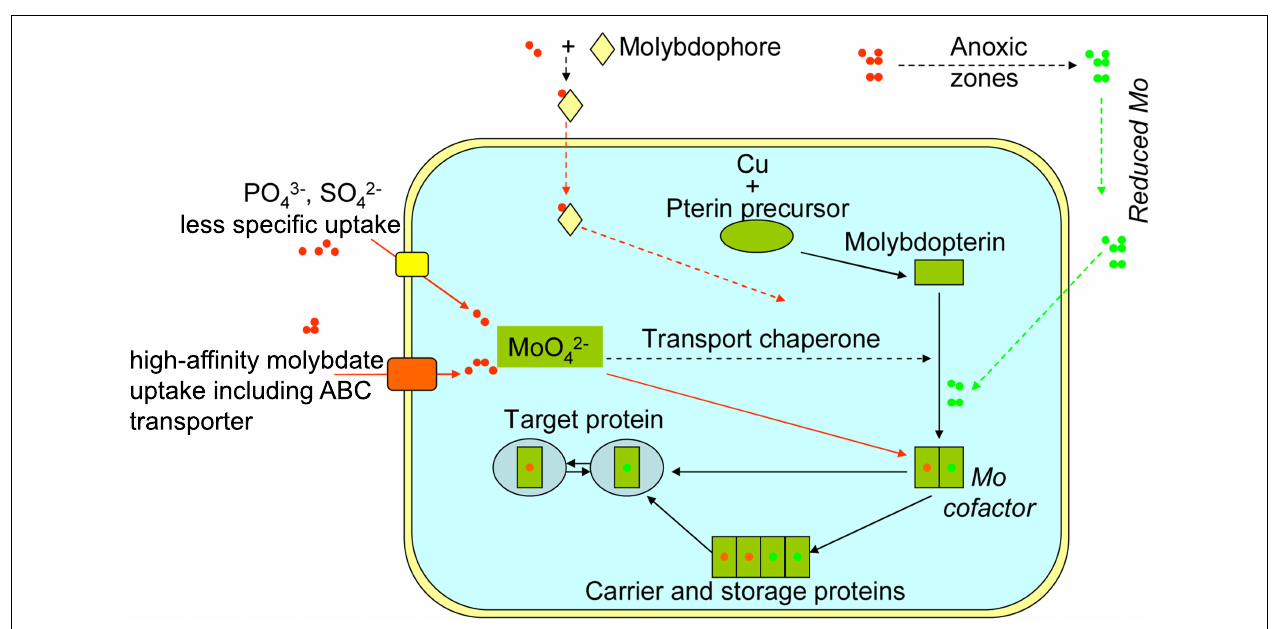
FIGURE 1 | Schematics of Mo uptake and storage in prokaryotic and eukaryotic cells. Routes represented by dashed lines were only identified in prokaryotes, while routes represented by solid lines occurred in both current prokaryotes and eukaryotes. Green dots refer to reduced Mo species, and red dots refer to oxidized Mo